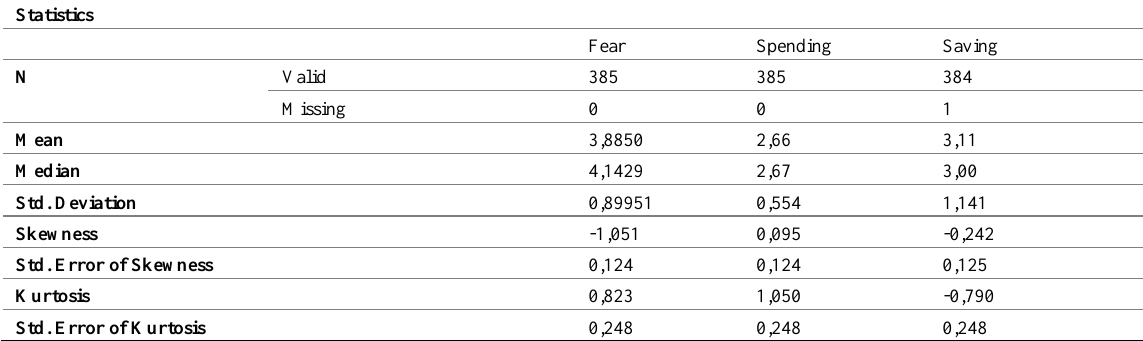
Table 1: Skewness and Kurtosis Test